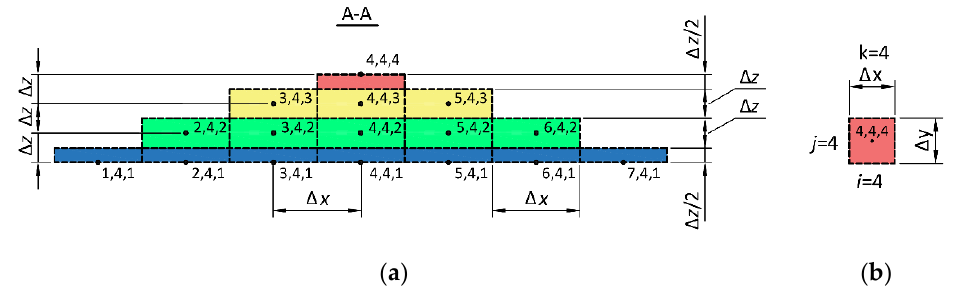
Figure 4. Dividing the plate into four control volumes in the z -axis direction: ( a ) cross-section through the center of the slab with marked nodes; ( b ) plane z = 3Δ z .